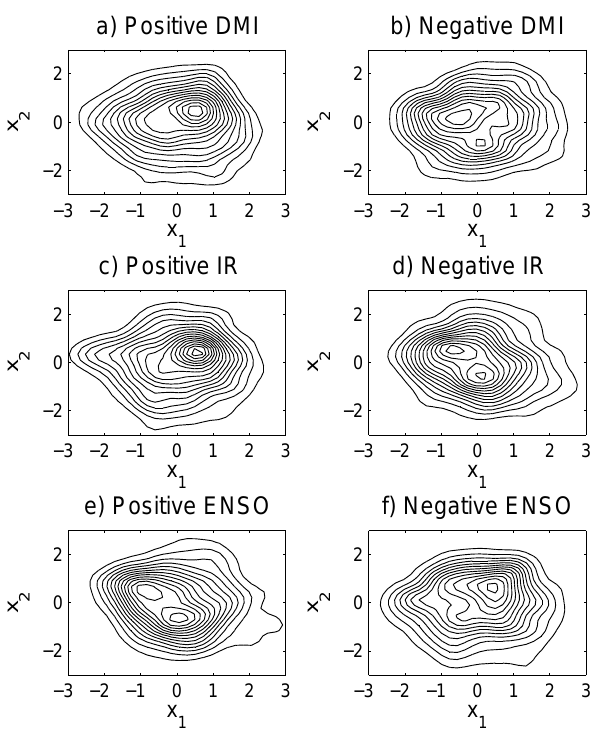
Fig. 13. Kernel PDF estimates of the leading two Isomap time se- ries during positive (a, c, e) and negative (b, d, f) phases of the dynamical monsoon (DMI/WY) index (a, b) , area-averaged India rainfall, IR, (c, d) and ENSO (e, f) Fig.13. KernelPDFestimatesoftheleadingtwoIsomaptimeseriesduringpositive(a,c,e)andnegative(b,d, f) phases of the dynamical monsoon (DMI/WY) index (a,b), area-averaged India rainfall, IR, (c,d) and ENSO (e,f).